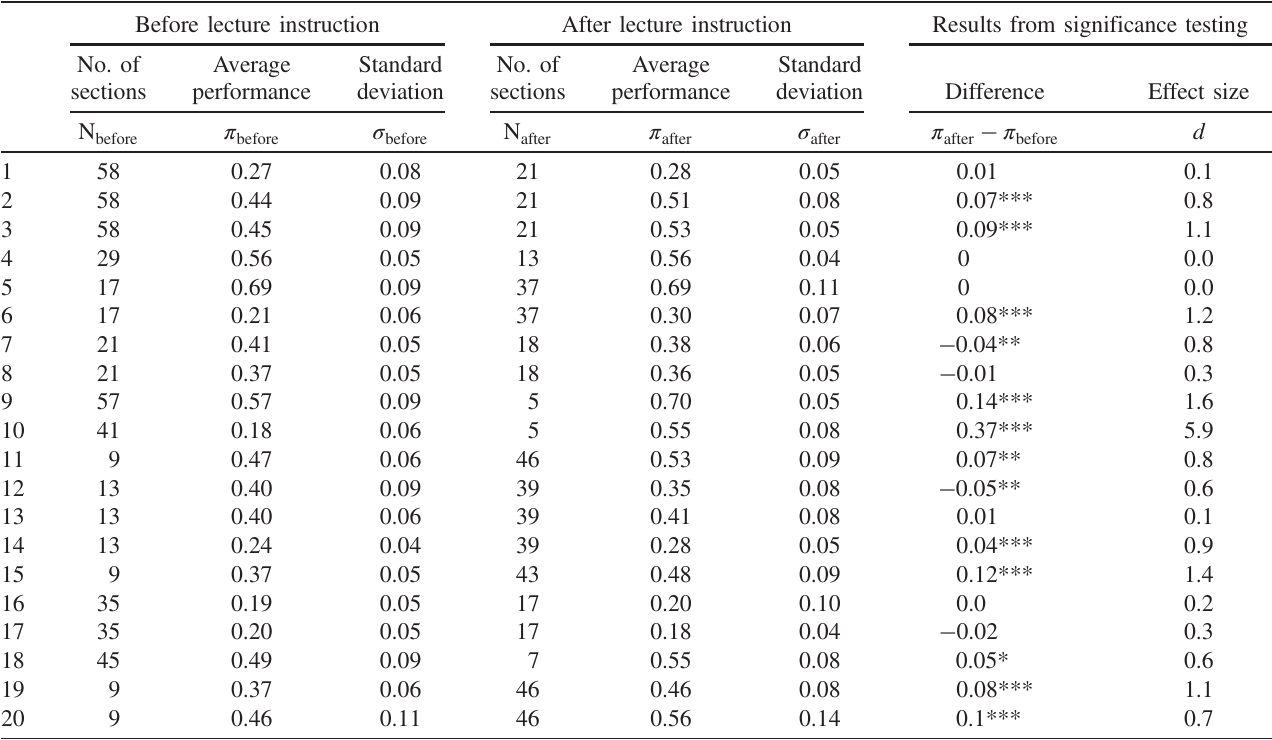
TABLE II. Summary statistics, results from hypothesis testing and effect